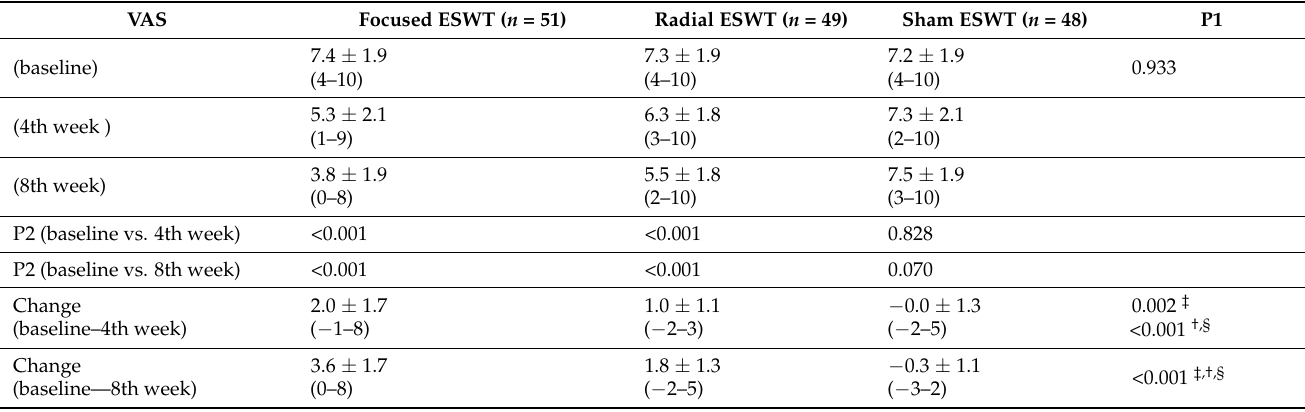
Table 2. Statistical analysis for the VAS scores.